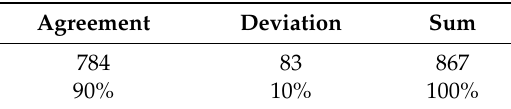
Table 4. Results from the statistical assessment.